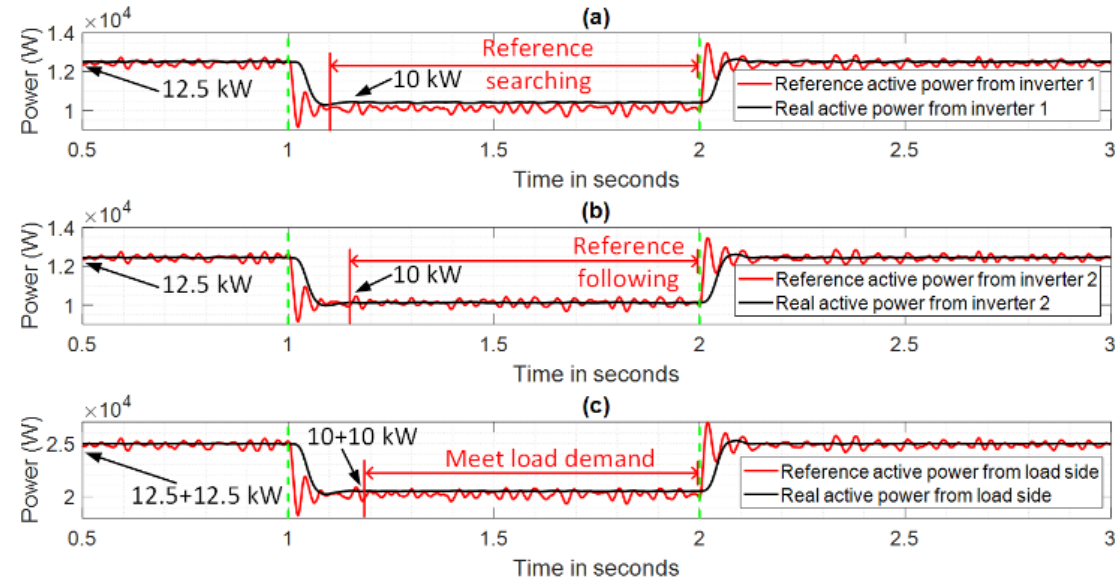
Figure 12. Active power tracking result with measured active power (black) and reference active power (red). ( a ) Active